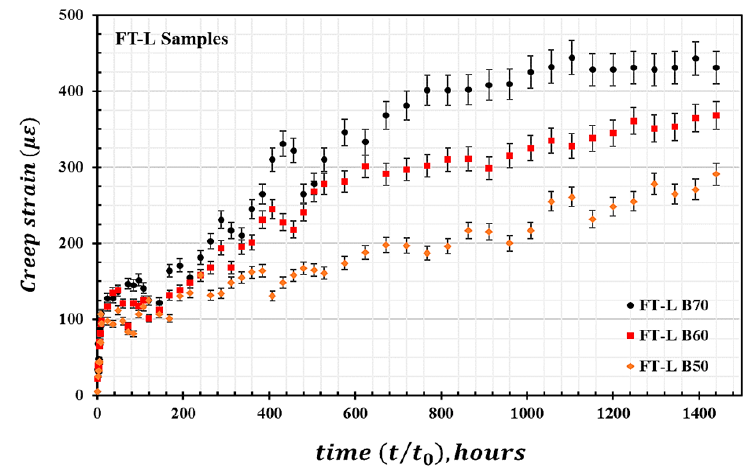
Figure 8. HFRP creep strain for samples loaded at 50–70% ultimate stress for FT-L samples.